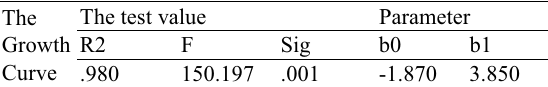
Table 12. The test value and parameters. The Growth Curve